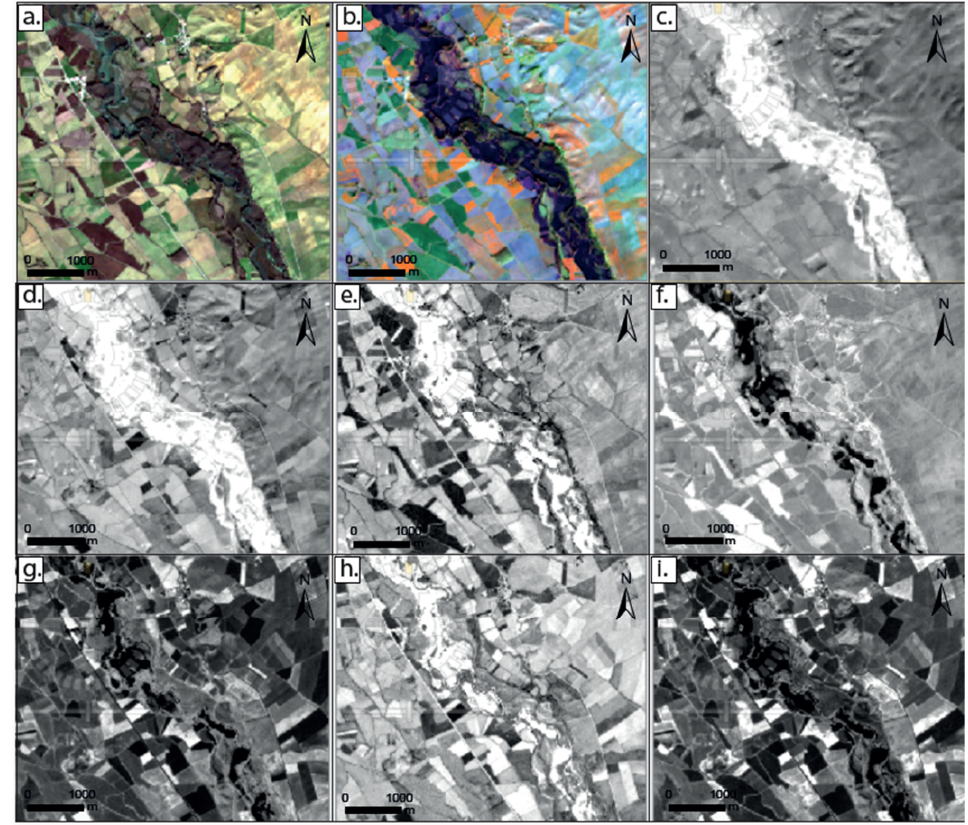
Figure 4. Flooded areas detected by each index used in the study area. ( a ) Real color image. ( b ) Composite image (R: 8, G: 11, B: 4). ( c ) AWEInsh. ( d ) AWEIsh. ( e ) MNDWI. ( f ) NDPI. ( g ) NDVI. ( h ) NDWI. ( i ) SAVI.